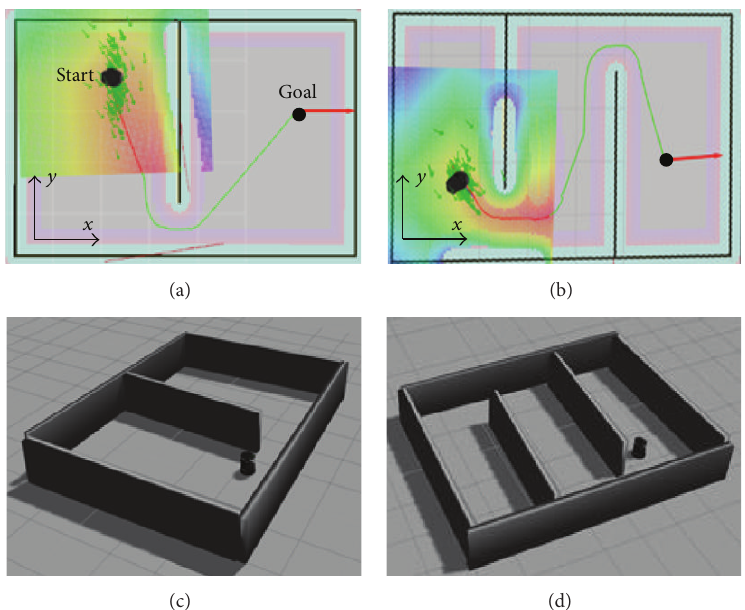
Figure5:Twodifferentmapsusedinoursimulation.(a)and(b)areactualmapsgeneratedbysoftware.(c)and(d)aresimulationenvironment corresponding to maps above them.